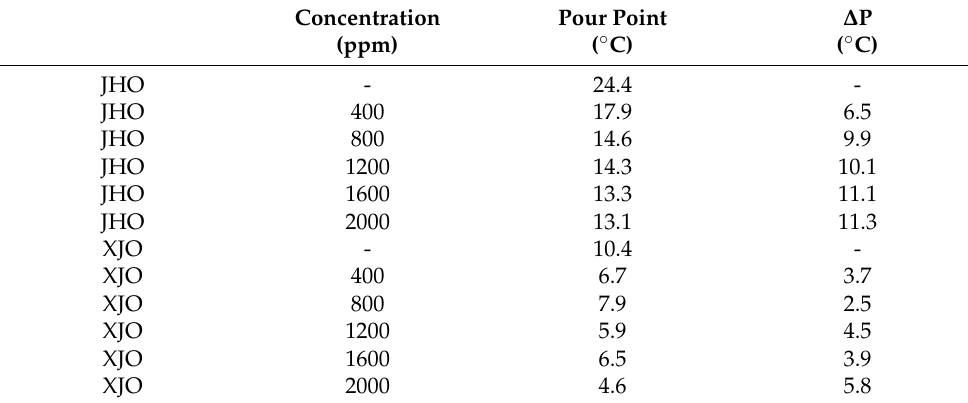
Table 2. Influence of CA C H on the pour point of crude oil.